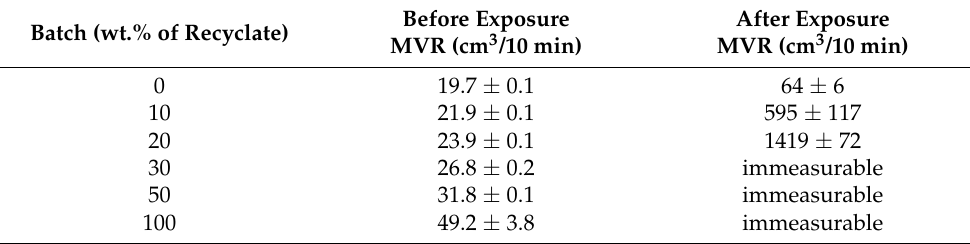
Table 5. Mean values for the melt flow volume index after exposure of the samples to elevated temperature.